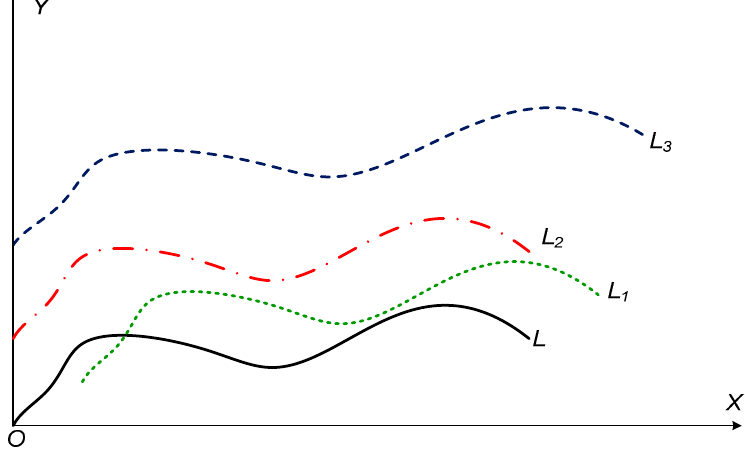
Figure 1. Translation and stretching transformation of curves.